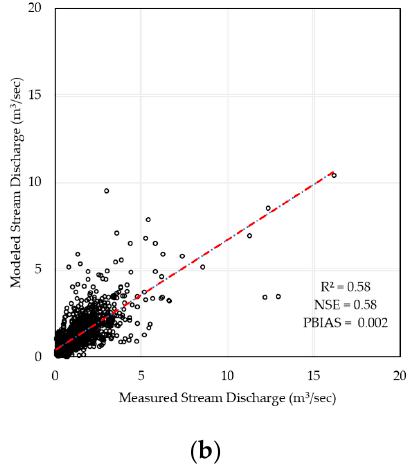
Figure 3. ( a ) Hydrograph and ( b ) scatterplot of observed versus SWAT modeled streamflow at Queen River USGS gauge 01117370 during calibration years 2000–2005.